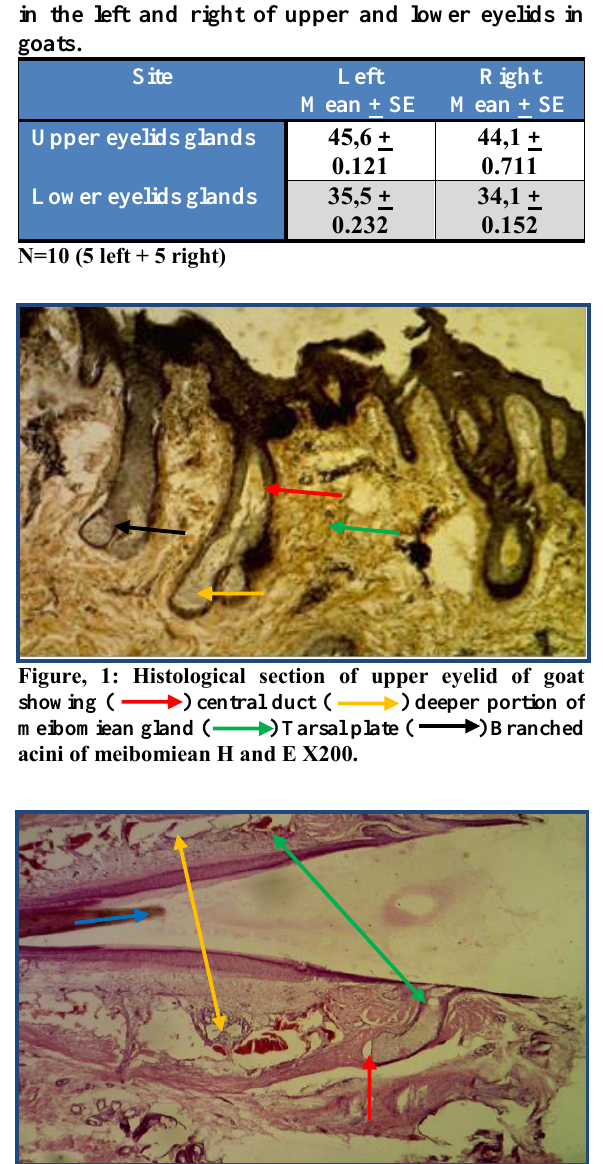
Figure, 2: Histological section of tarsal plate